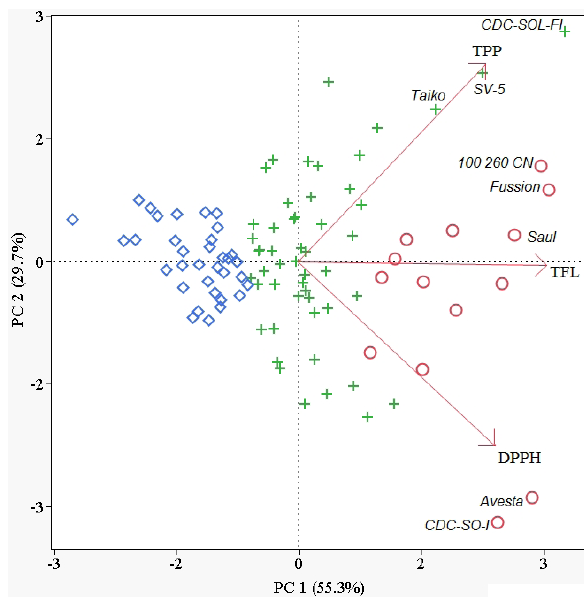
Figure 2: The principal component analysis of total polyphenols (TPP), total flavonoids (TFL), and radical scavenging activity (DPPH) (shape and color of individual points representing oat genotypes is the same as in dendrogram in Fig. 3).